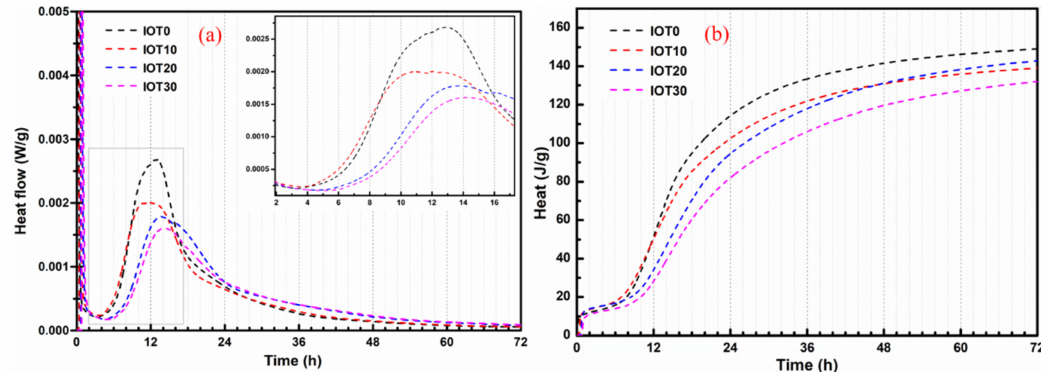
Figure 9. Calorimetry test results of UHPC pastes with different lead-zinc tailings contents: ( a ) Normalized heat flow and ( b ) normalized total